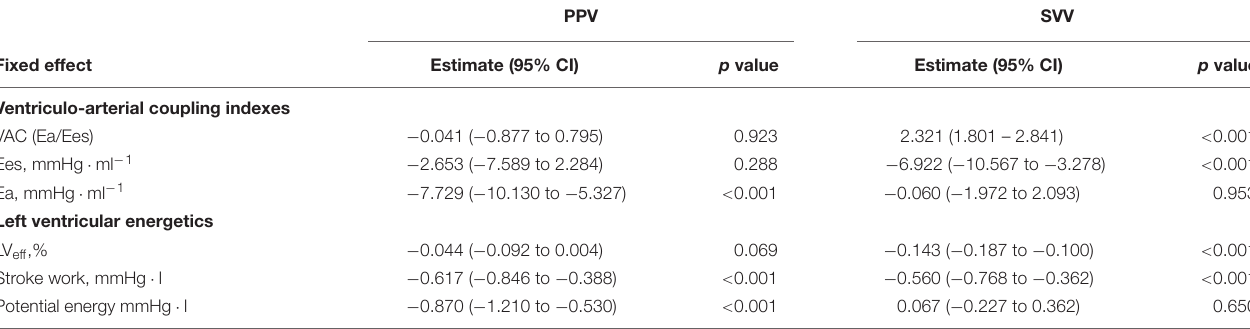
TABLE 5 | Estimated values of fixed effects on aortic pulse pressure variation (PPV) and stroke volume variation (SVV) according to a mixed-effect regression model.